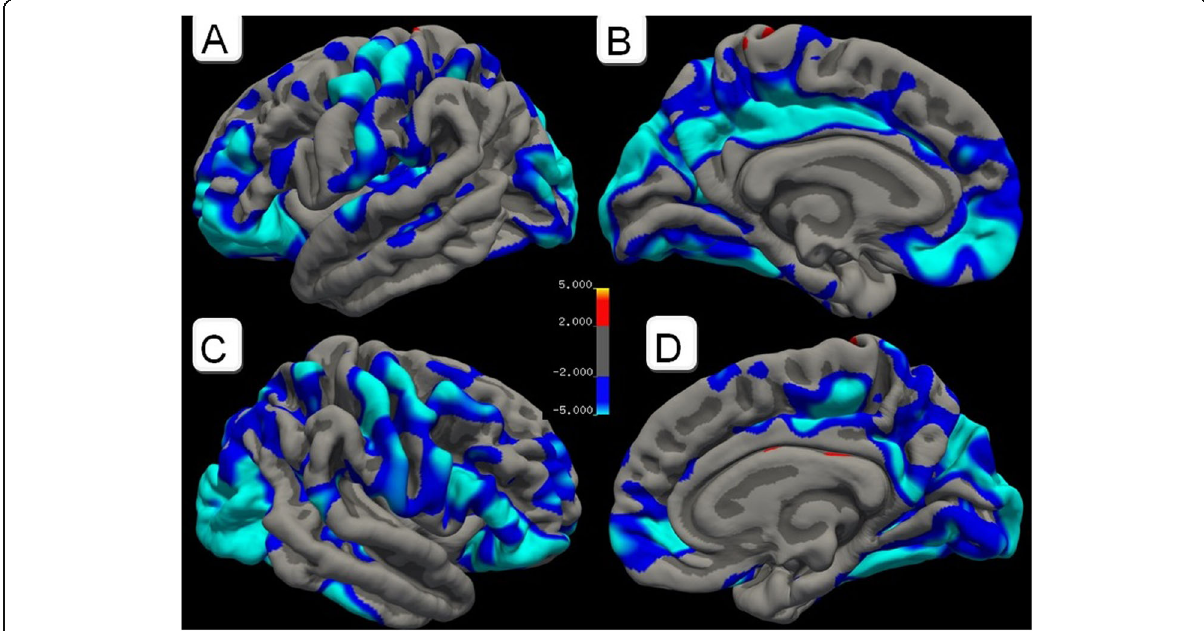
Fig. 2 Brain surface demonstrating significant differences between youth with conduct disorder (CD only) versus healthy control youth. a Left lateral. b Left medial. c Right lateral. d Right